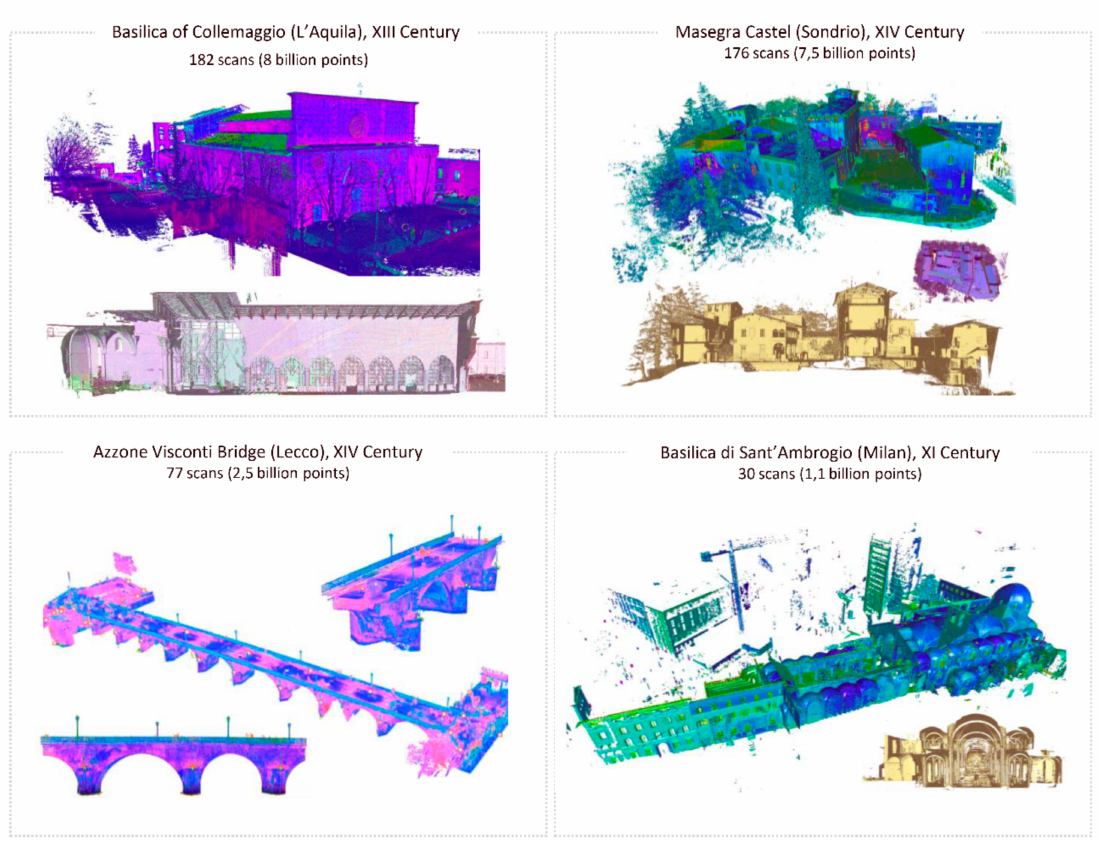
Figure 5. TLS surveys of research case